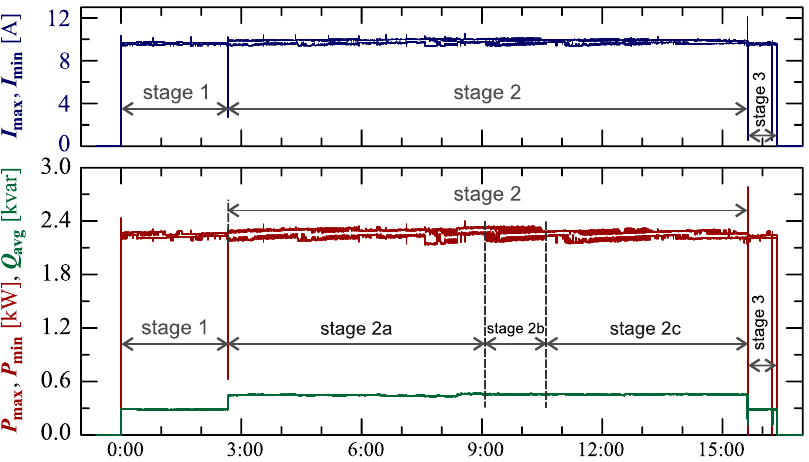
Figure 34. The characteristics of maximum P max = f ( t ) and minimum P min = f ( t ) values of active power and average values of reactive power Q agv = f ( t ) for Case V.